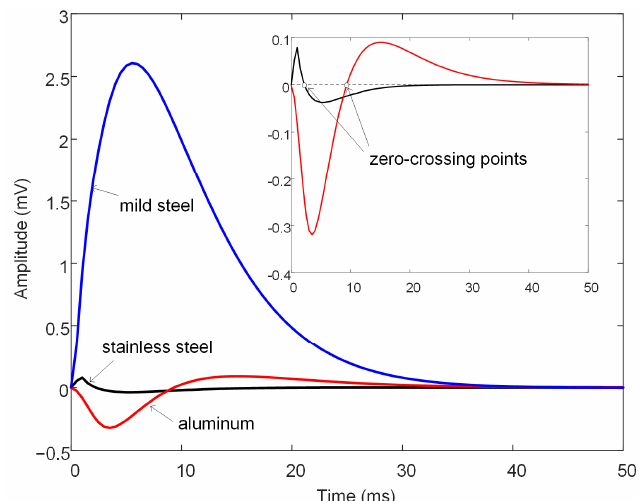
Figure 3. Simulated differential signals for metal meshes of different materials. In the upper right corner is a zoomed-in plot of the low-amplitude signals.